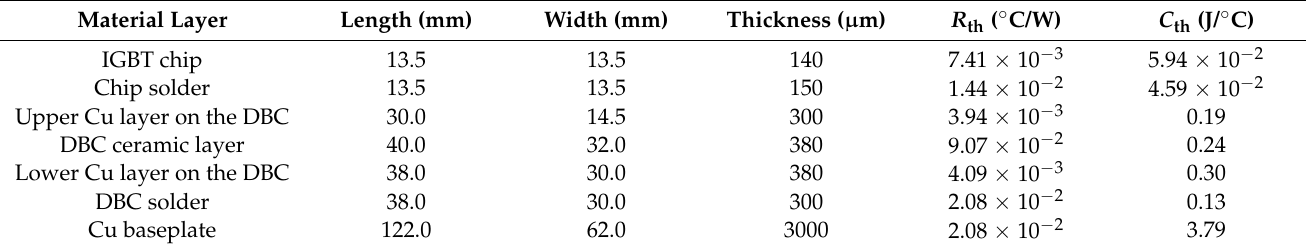
Table 2. Theoretically calculated thermal resistance and thermal capacitance of each layer in the IGBT module.